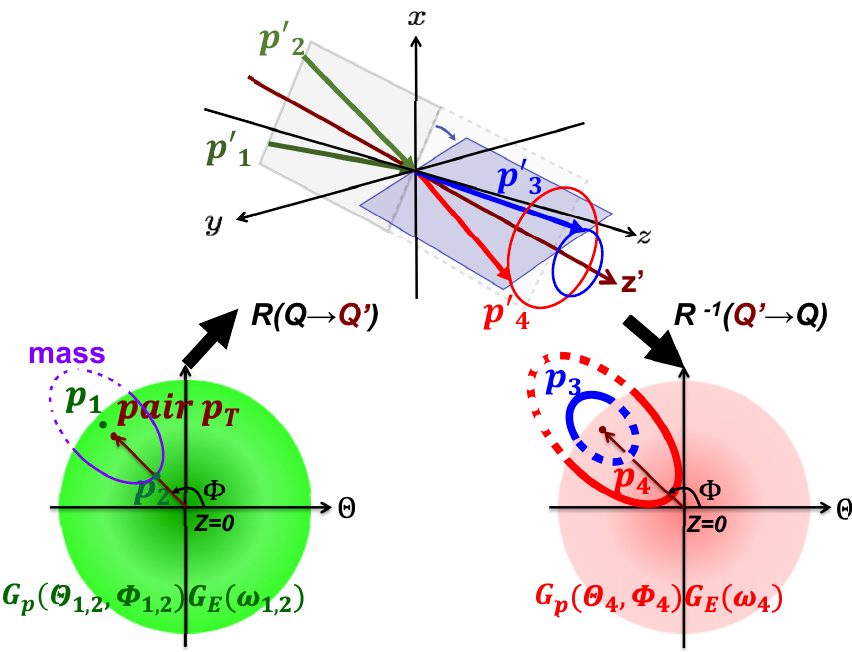
Figure 4 . Flow of numerical calculations. The details are explained in the main